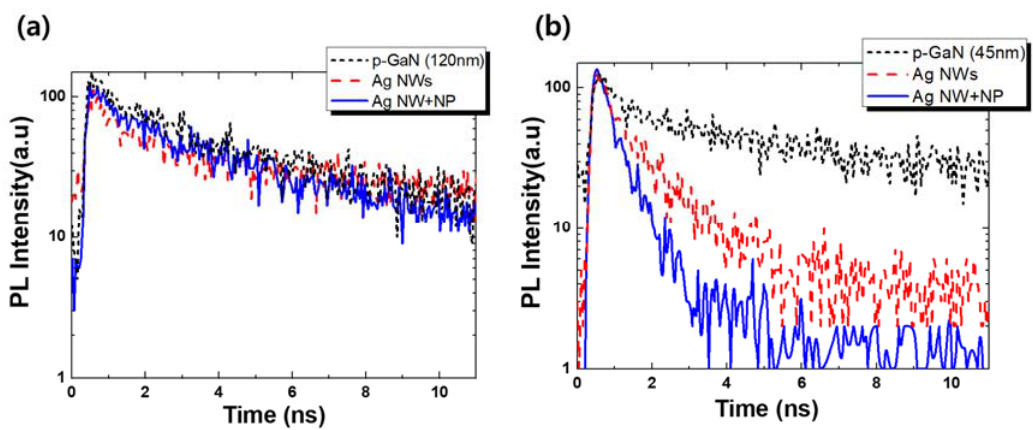
Figure 5. Time-resolved PL spectra of blue LEDs without TCE and with and without Ag NPs with ( a ) 120 nm thick and ( b ) 45 nm thick p-GaN layer.